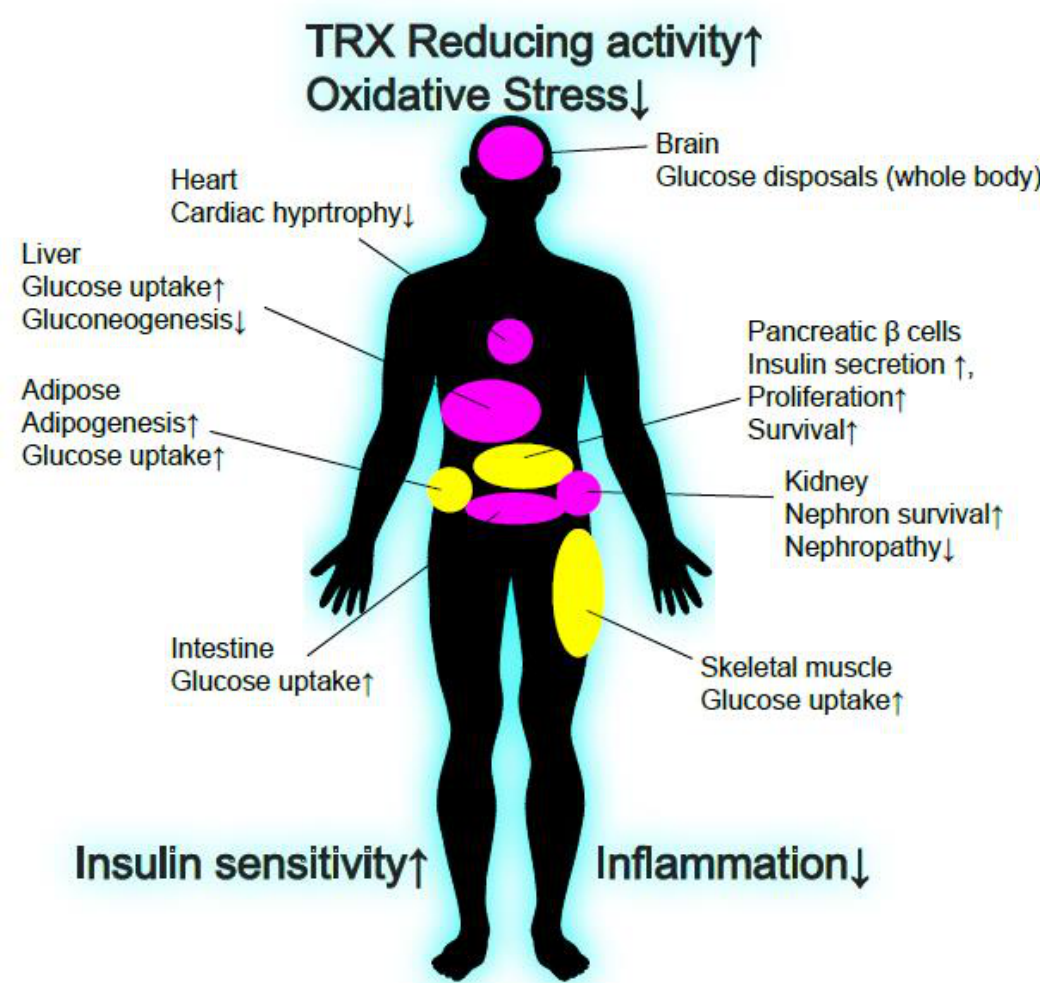
Figure 3. Beneficial effects of TXNIP inhibition for glucose homeostasis. Known effects of TXNIP